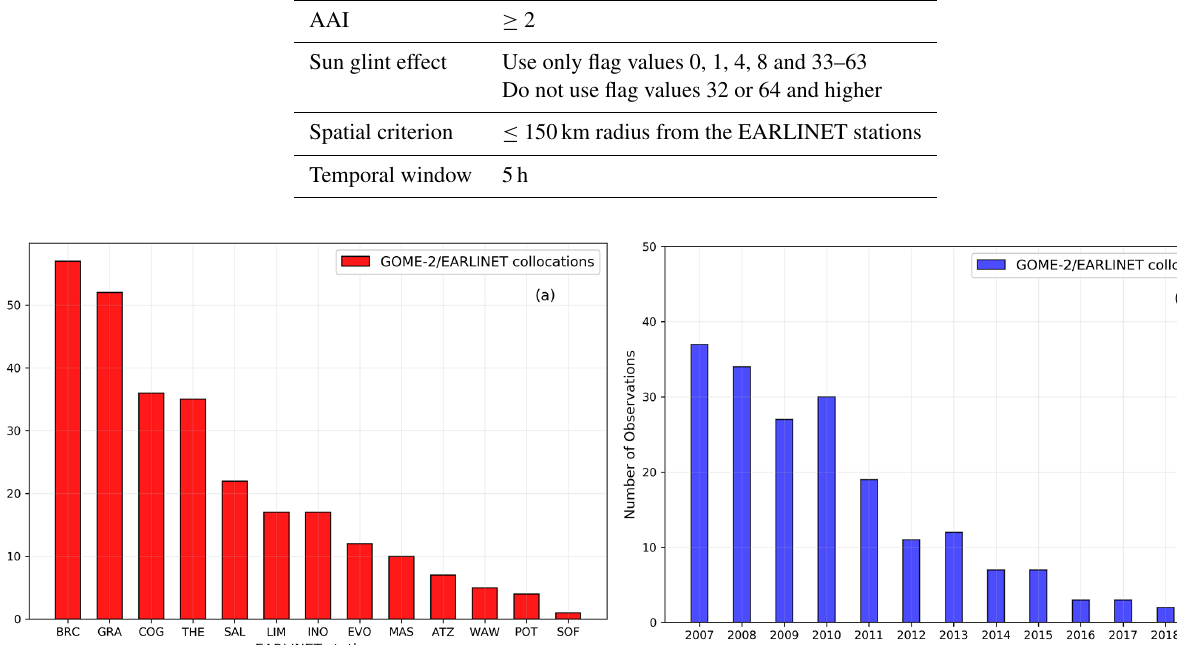
Figure 4. Distribution of collocated cases with minimum distance from each lidar station, for a radius distance of 150km around each EARLINET station (a) and distribution of all collocated cases by year for the study period (2007–2019) (b) . Refer to Table 2 for the EARLINET code names shown in the x axis.